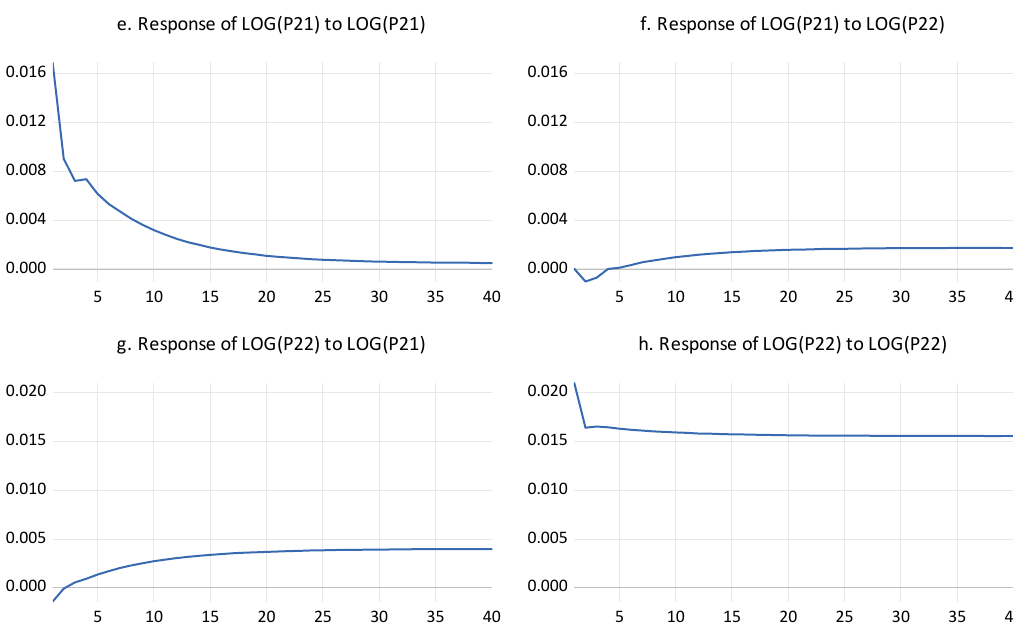
Figure A2. Impulse response estimates for curd prices in the Central and Northern regions, Poland, 5 January 2014–5 November 2017. ( e ) Response of curd prices in Central region to region’s lagged prices. ( f ) Response of curd prices in Central region to lagged prices in Northern region. ( g ) Response of curd prices in Northern region to lagged prices in Central region. ( h ) Response of curd prices in Northern region to region’s lagged